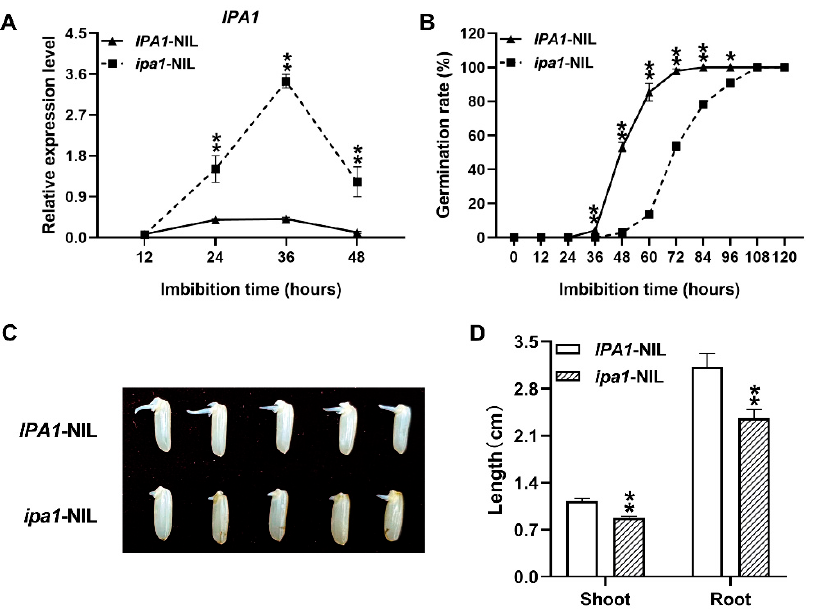
Figure 1. IPA1 participates in seed germination and early seedling growth in rice. ( A ) The relative expression level of IPA1 in the NILs. ( B ) Seed germination was comparatively delayed in ipa1 -NIL plants. ( C ) Morphology of dehulled seeds at 48 h after initial imbibition. ( D ) The shoots and roots were significantly shorter in ipa1 -NIL plants compared with IPA1 -NIL plants after 96 h germinated in the Petri dishes at 30 °C. Values are means ±SE ( n = 3). More than 50 seeds were measured in each replicate. Significant differences were determined using Student’s t -test (* p < 0.05, ** p < 0.01).